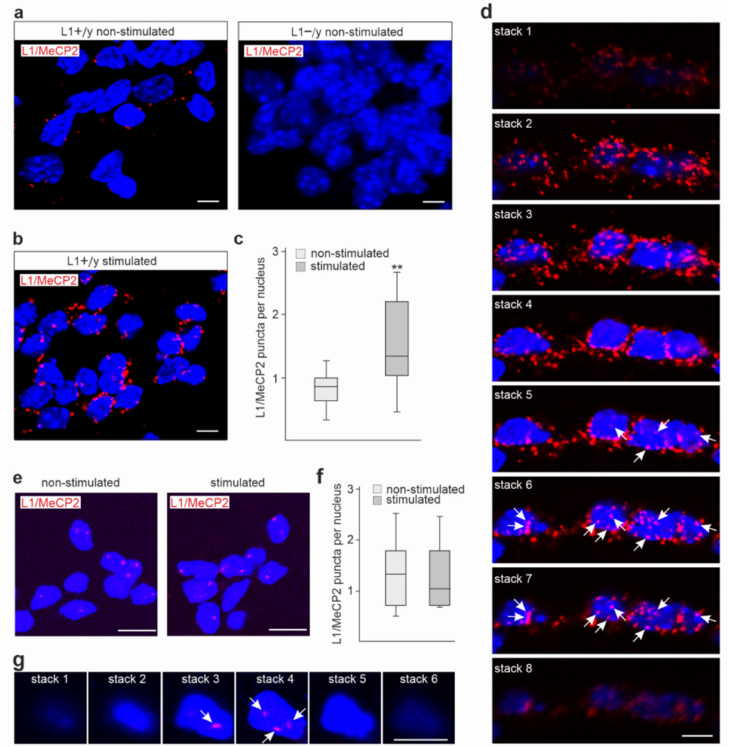
Figure 2. Interaction of L1 with MeCP2 in cultured cerebellar and cortical neurons. ( a – c ) Cultured cerebellar neurons from wild-type (L1+/y) ( a , b , d ) and L1-deficient (L1 − /y) ( a ) mice were treated without (non-stimulated) or with (stimulated) function-triggering L1 antibody 557 and then subjected to proximity ligation assay with L1 and MeCP2 antibodies. ( e , g ) Cortical neurons from